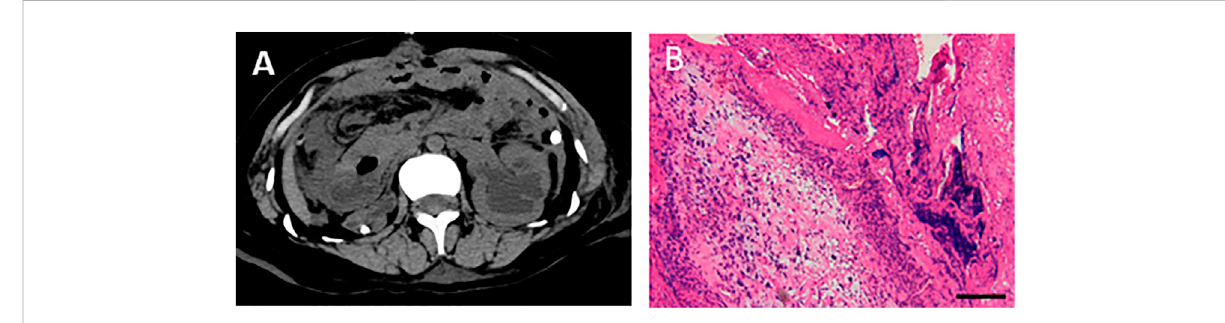
FIGURE 4 Abdominal CT images after gastric perforation and the pathological detection for gastric tissues. (A) Abdominal CT image after gastric perforation. (B) HE staining was performed with gastric tissues, showing in fl ammatory cells in fi ltrated and fi broblasts proliferated in the fi brous connective tissue of gastric tissue at pyloric perforation. Bar = 200 μ m.